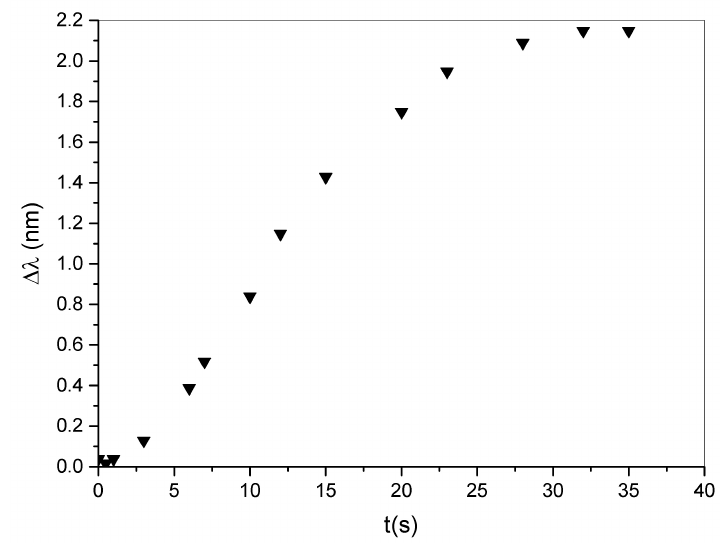
Figure 6. Wavelength shift as a function of time. By removing the compression, the system returns to the initial state.